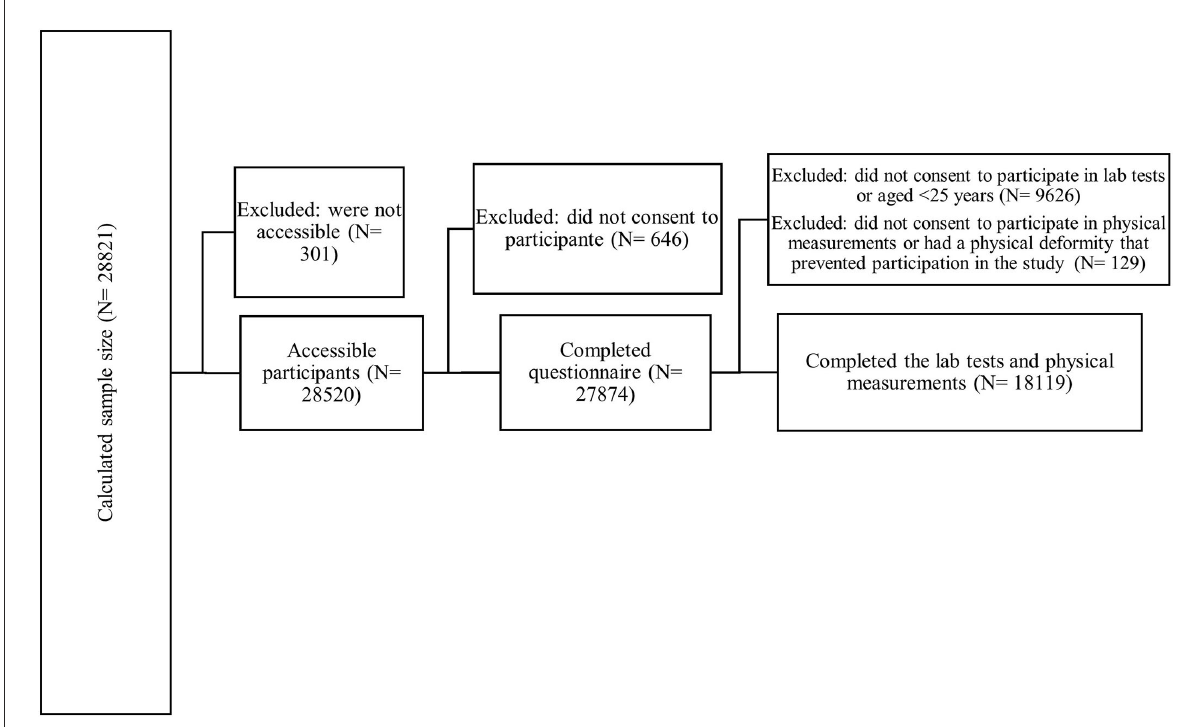
FIGURE1 Flow diagram of study